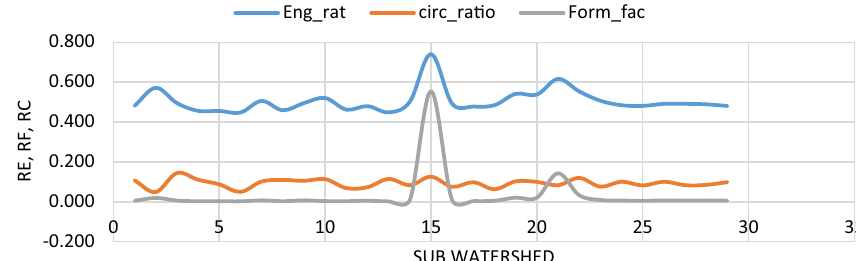
Fig. 7 The relation between dif- ferent shape parameters shows decrease values